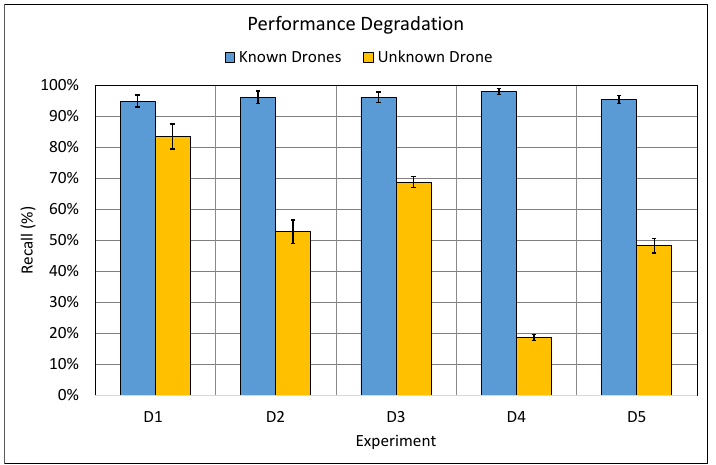
Figure 8. The performance,in terms of recall , of the average CNN models trained on the R4 drone dataset and tested on known (recorded) drone types (which the model has seen during the training phase). Whereas, the yellow bars are when tested on new and unknown types of